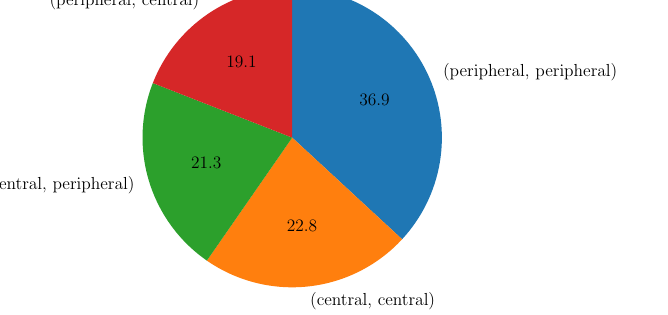
Figure 9. Number of trips classified according to two-zones division with respect to total number of rips.